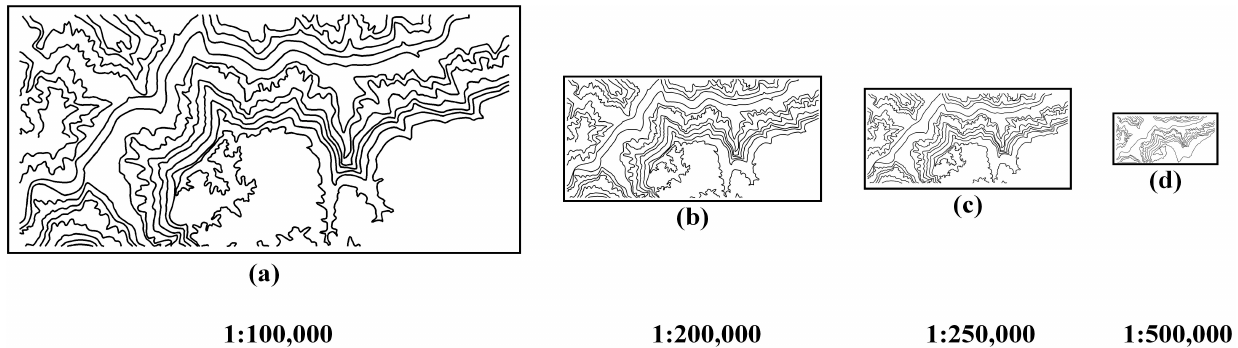
Figure 18. Simplified contours generated by CCSM at the 1:100,000 ( a ), 1:200,000 ( b ), 1:250,000 ( c ), and 1:500,000 ( d ) scales.